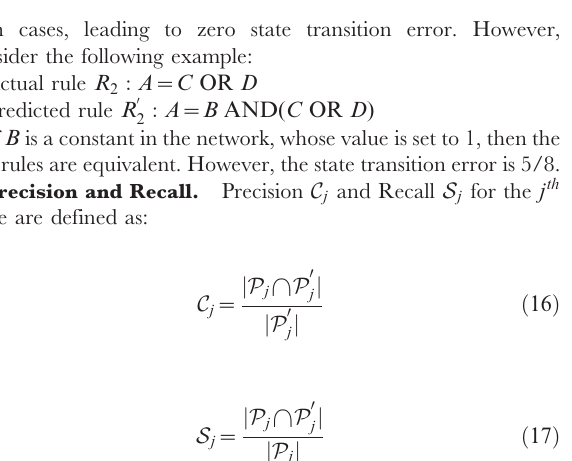
Figure 7. Evaluation of the network with varying indegrees using REVEAL. Figure A is the noise level vs. state transition error, Figure B is a plot of noise level vs. recall and Figure C indicates the noise level vs. precision. Noise level is the standard deviation s of Gaussian distribution with zero mean. In Figure D different evaluation measures are plotted for different indegrees for noise level 0.1 and indegree l ~ 4 . All experiments were carried out using 10 simulations.